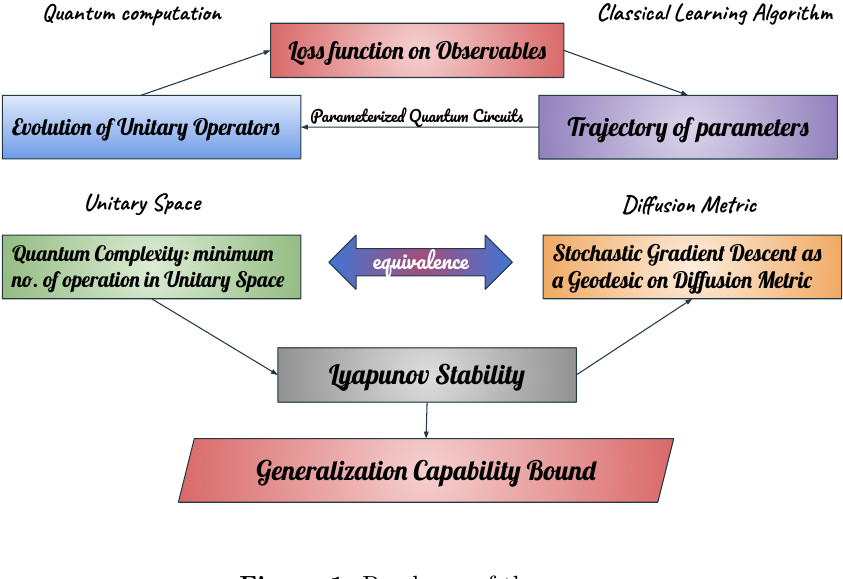
Figure 1 . Roadmap of the